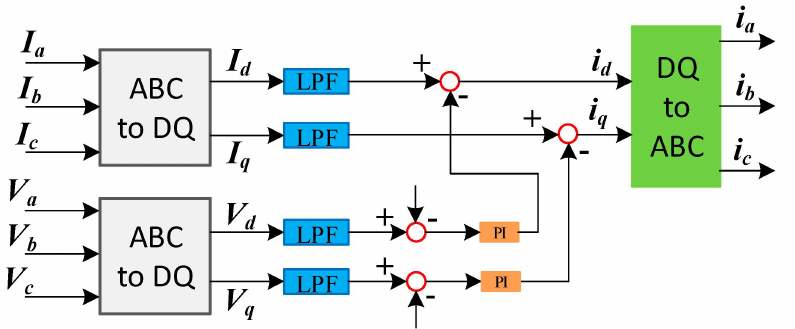
Figure 20. A control scheme of a synchronously rotating reference